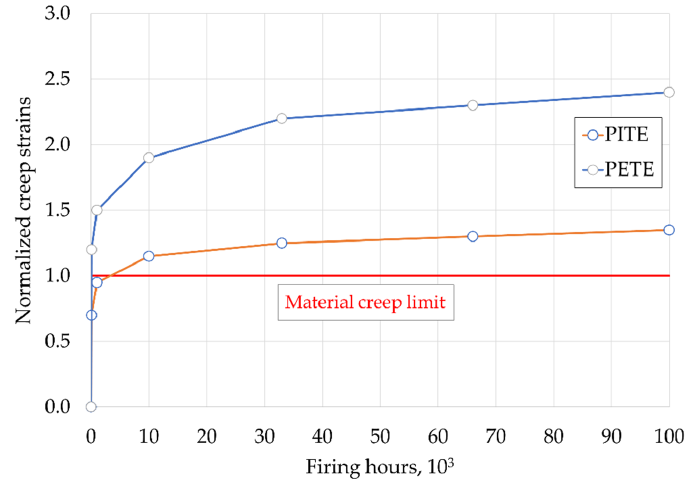
Figure 16. Normalized creep strains vs. firing hours at the PETE and PITE.